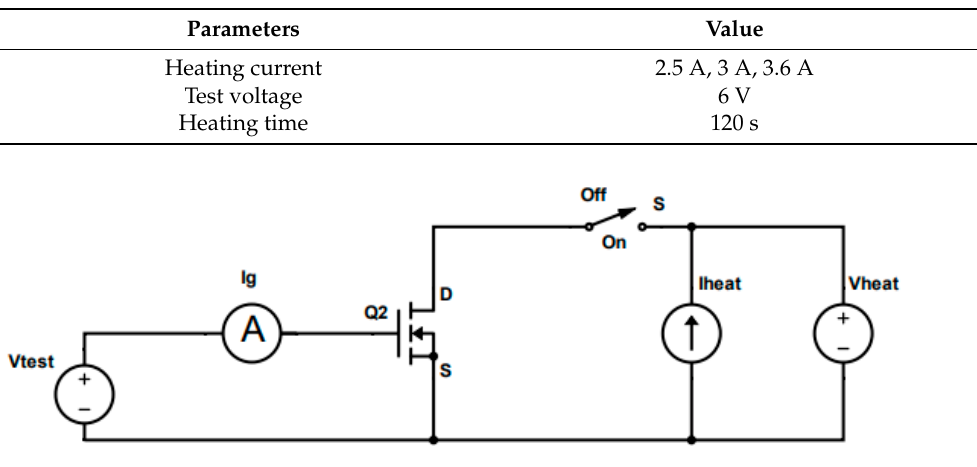
Figure 17. Measurement electrical circuit for I g.